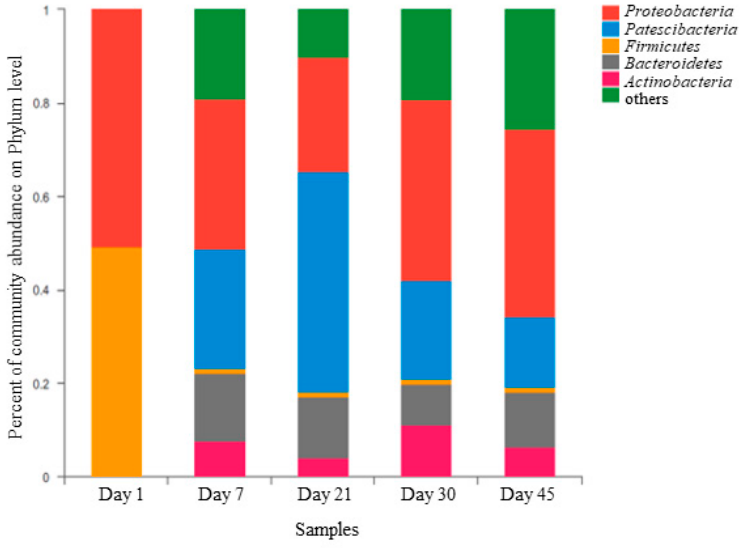
Figure 3. Circos plot of microbial community (abundance greater than 1%) dynamics of the biofilm samples during different phases at the phylum level.